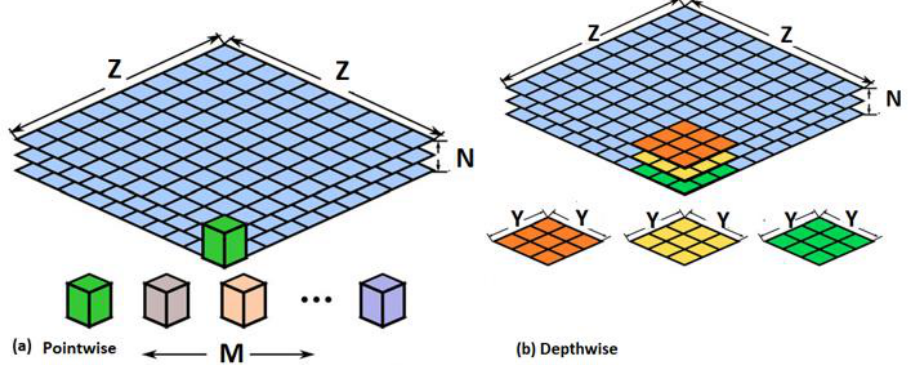
Figure 4. The architecture of MobileNet CNN: ( a ) pointwise convolution layer, ( b ) depthwise (dw) convolution layer. Table 4. The general structure of MobileNet CNN.